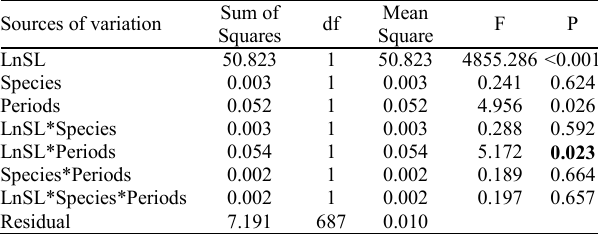
Table 1. Covariance analysis for the natural logarithm (Ln) of total weight (TW - dependent variable) in relation to the following factors: standard length (SL - covariate), species ( Cyphocharax nagelii and Steindachnerina insculpta levels), and periods (dry and wet levels) (n = 695; r 2 = 0.93).